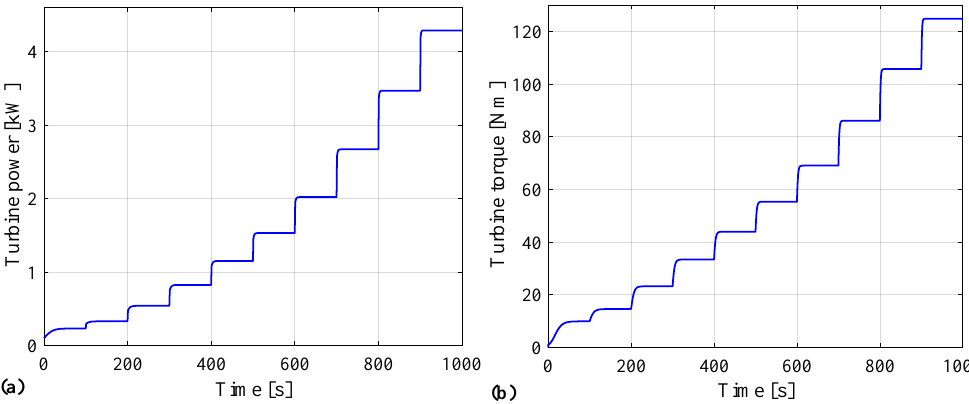
Figure 12. ( a ) Turbine speed and ( b ) turbine torque responses for wind speed variation versus time.